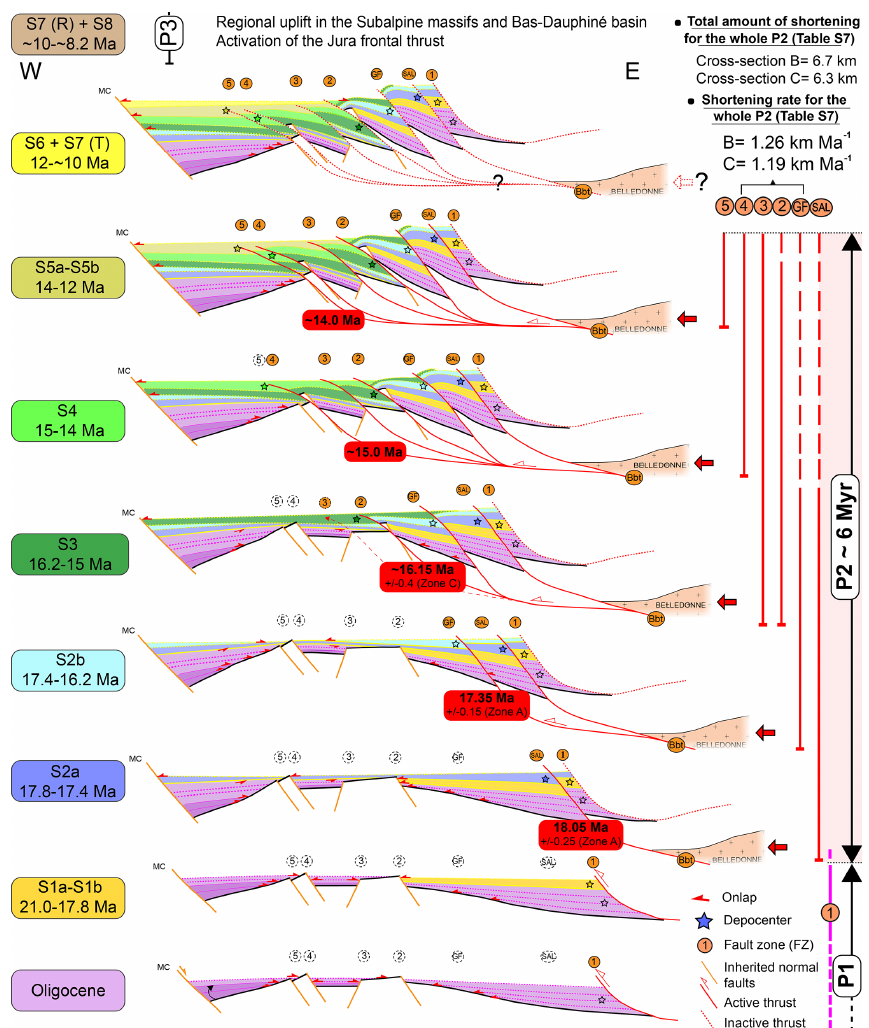
Figure 17. Schematic framework summarizing the main phases of thrust propagation at the western Alpine front and their chronology based on a thorough revision of the regional chronostratigraphy between the Oligocene and the late Miocene. The horizontal and vertical scales are not respected. MC: Massif Central; P: tectonic phase; T: transgressive deposits; R: regressive deposits. The colored boxes on the left side correspond to the homogenized ages of the eustatically driven depositional sequences (Fig. 4A, B). Red boxes highlight the timing of fault initiation deduced from depocenter migration (Fig. 13). Vertical lines on the right represent the proposed timing of activity for each fault.